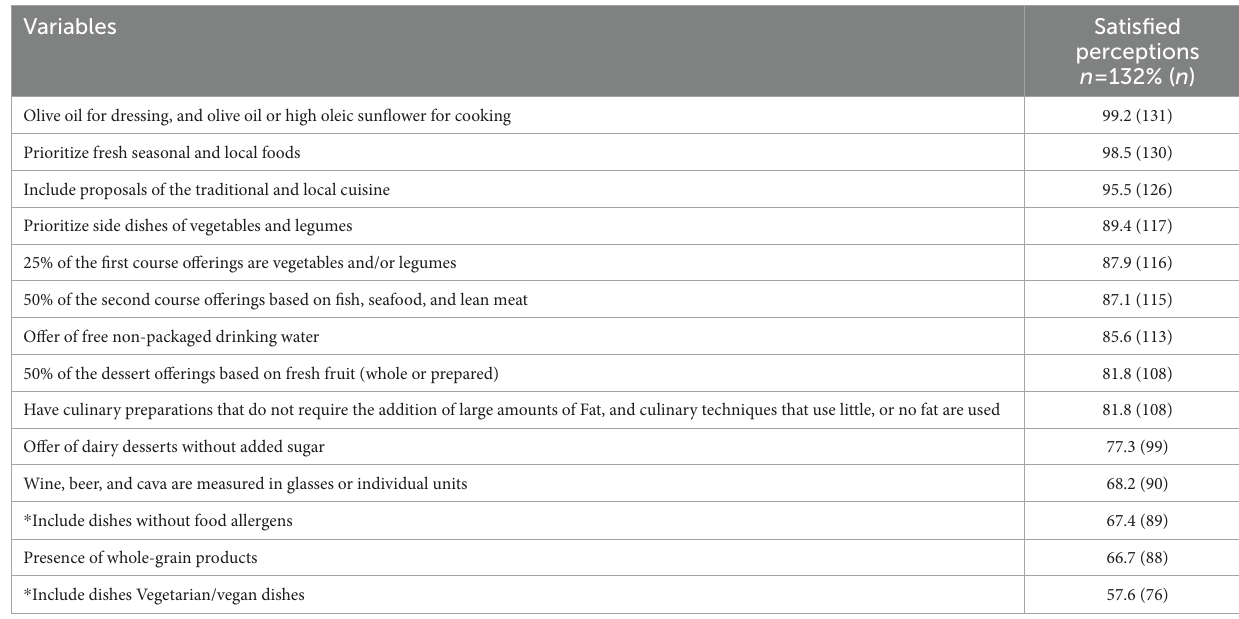
TABLE 4 Perceptions of each AMed criteria satisfied by the restaurant menu offerings (Mediterranean offerings).